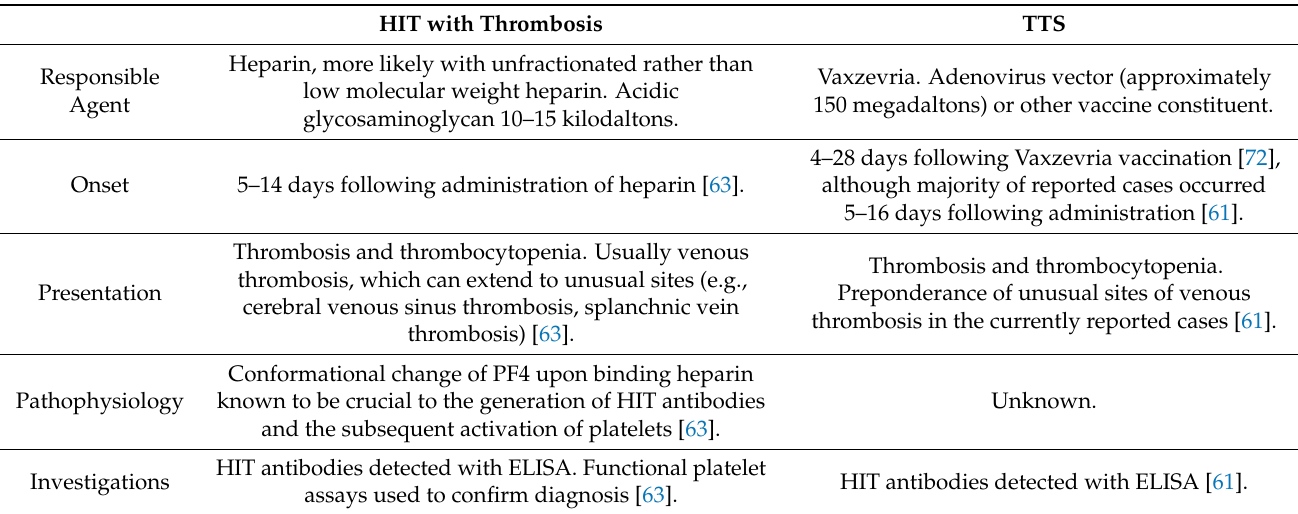
Table 1. Comparison between HIT with thrombosis and